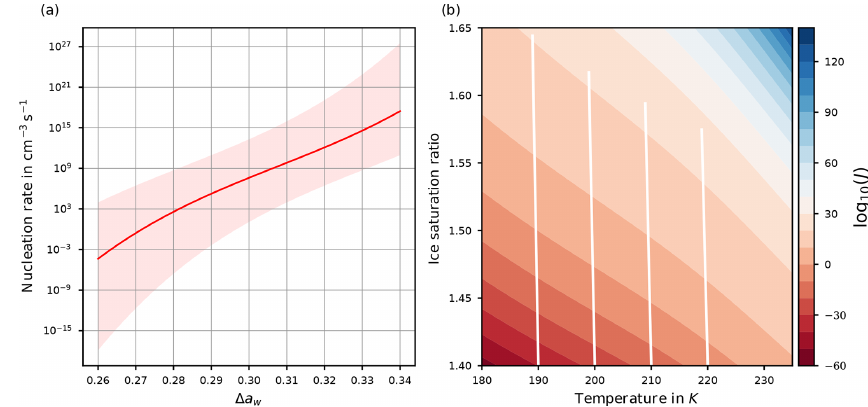
Figure 2. (a) Homogeneous nucleation rate coefficient J as a function of the difference (cid:49)a w of water activities. The light-red shaded area indicates the range of values of J if the ± 2 . 5% uncertainty of the water activity data is taken into account; see Koop (2004); Koop et al. (2000). (b) log 10 ( J ( S i ,T )) as a function of temperature and environmental humidity S i by adopting the equilibrium assumption for the solution particles. The white curves show the evolution of temperature and humidity for an air parcel ascending for 1h with velocity 0.03ms − 1 , starting at the